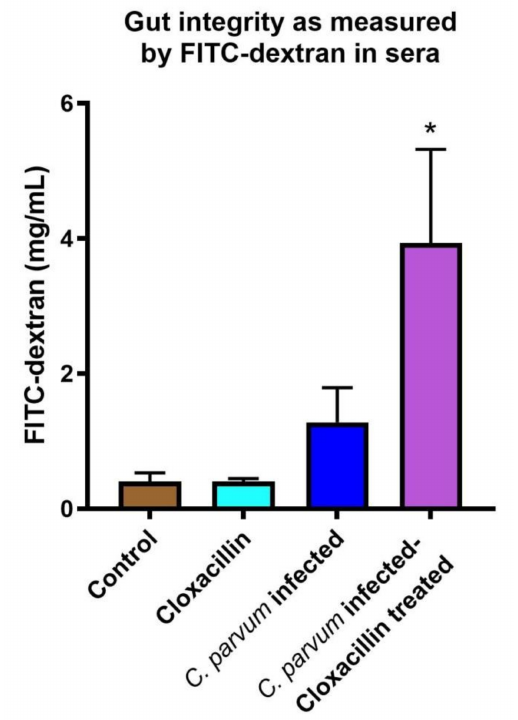
Figure 4. Permeability of the gut barrier. Serum FITC-dextran increased significantly in infected IL-12 KO mice treated with cloxacillin compared to uninfected controls ( p < 0.008) as denoted by asterisk. Uninfected cloxacillin treated mice did not exhibit increased permeability.